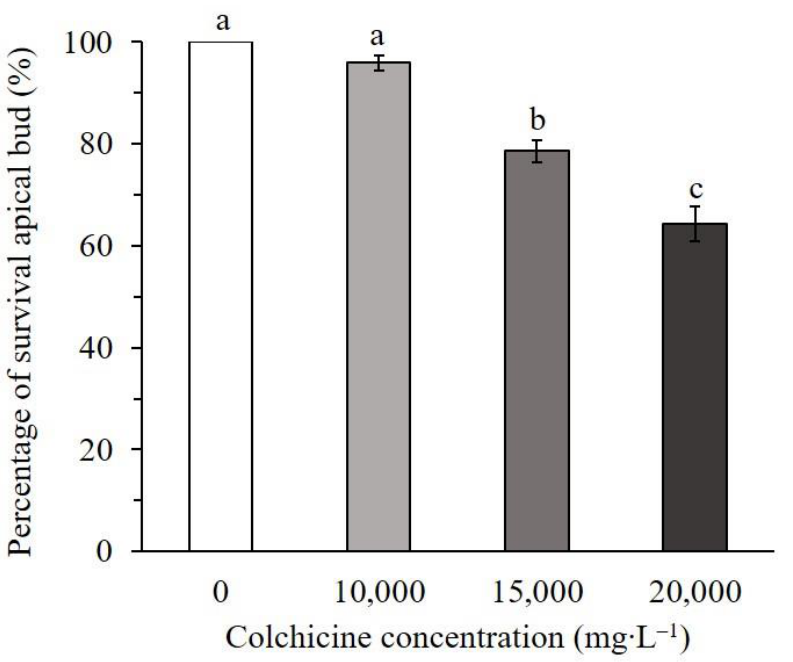
Figure 2. Effect on percentage survival of apical buds in ‘103-1’ ( Kalanchoe garambiensis ‘Type 1’ × K. nyikae ) at different concentration of colchicine treatment. The data represent means ± SD from three repeats (n = 32 to 33 plants). Different letters indicate significant differences between each other at p < 0.05 using one-way ANOVA with Tukey’s HSD test.